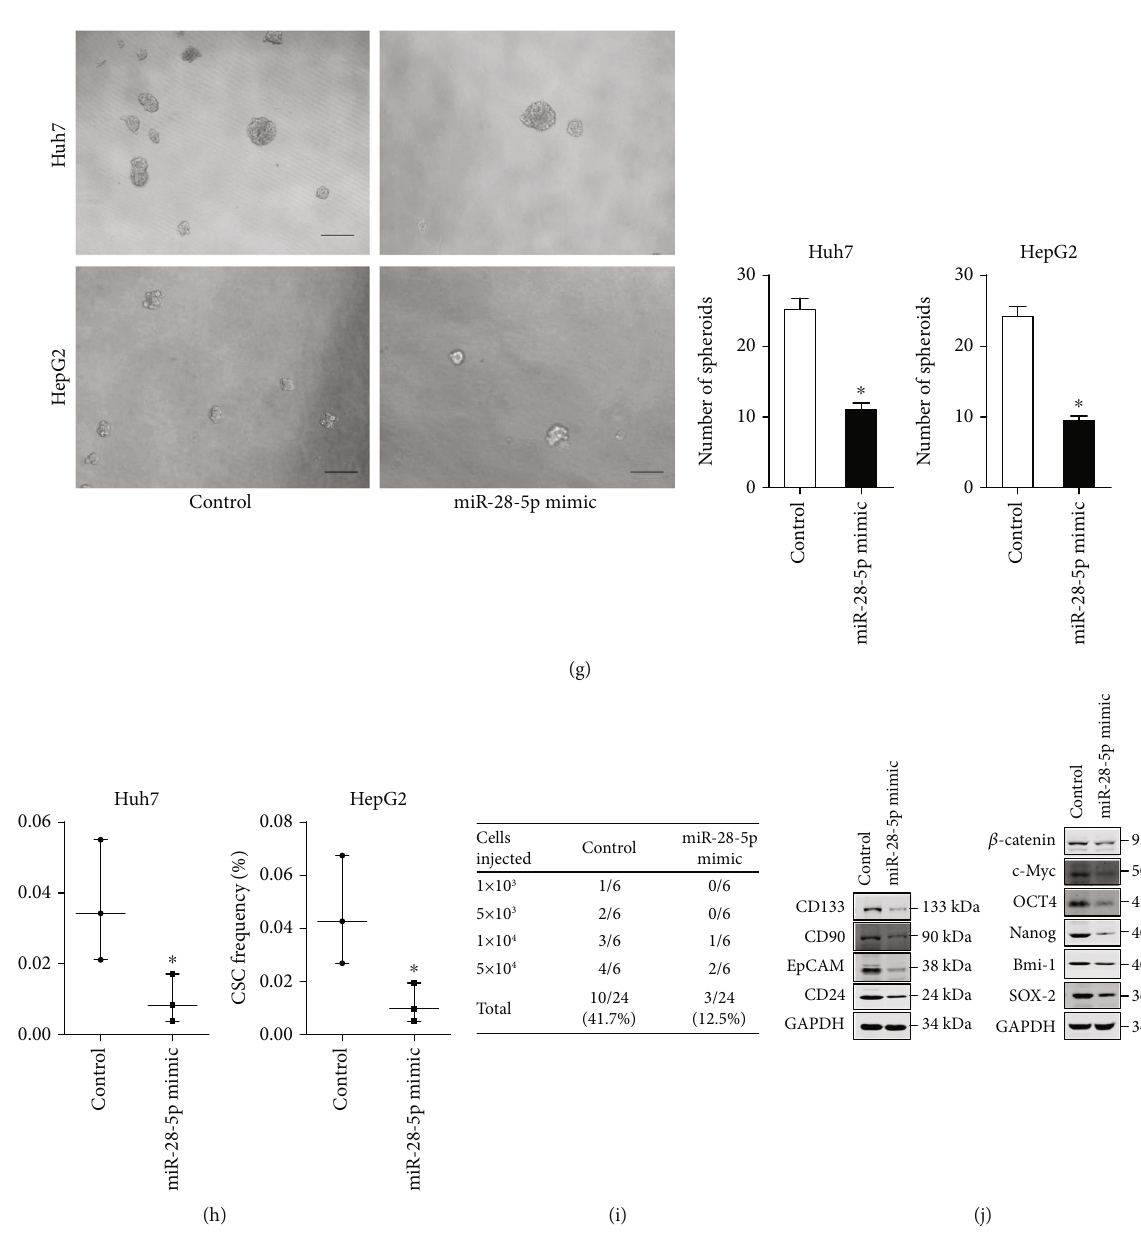
Figure 3: miR-28-5p overexpression suppresses liver CSC expansion. (a) Hepatoma cells were infected with the miR-28-5p mimic virus and control virus. The miR-28-5p overexpression e ff ect was determined by RT-PCR assay ( n = 3 ). (b) The mRNA expression of liver CSC markers in the miR-28-5p mimic and control HCC cells was checked by RT-PCR assay ( n = 3 ). (c) The protein expression of liver CSC markers in the miR-28-5p mimic and control HCC cells was checked by western blot assay. GAPDH acted as a loading control. (d) The mRNA expression of stemness-associated genes in the miR-28-5p mimic and control HCC cells was checked by RT-PCR assay ( n = 3 ). (e) The protein expression of stemness-associated genes in the miR-28-5p mimic and control HCC cells was checked by western blot assay. GAPDH acted as a loading control. (f) The EpCAM-positive cells in the miR-28-5p mimic and control HCC cells was determined by fl ow cytometry ( n = 3 ). (g) The self- renewal ability of the miR-28-5p mimic and control HCC cells was compared by spheroid formation assay ( n = 3 ). (h) In vitro limiting dilution assay of the miR-28-5p mimic and control HCC cells. The results are shown as a natural logarithm of the proportion of CSCs ( n = 6 ). (i) The tumorigenicity of liver CSCs in the Huh7 miR-28-5p mimic and its control cells was compared by in vivo limiting dilution assay. Tumors were observed over 2 months; n = 6 for each group. (j) The protein expression of liver CSC markers and stemness- associated genes in the above xenograft tumors was checked by western blot assay. GAPDH acted as a loading control. Data are represented as mean ± s : d : ; ∗ P < 0 : 05 ; two-tailed Student ’ s t